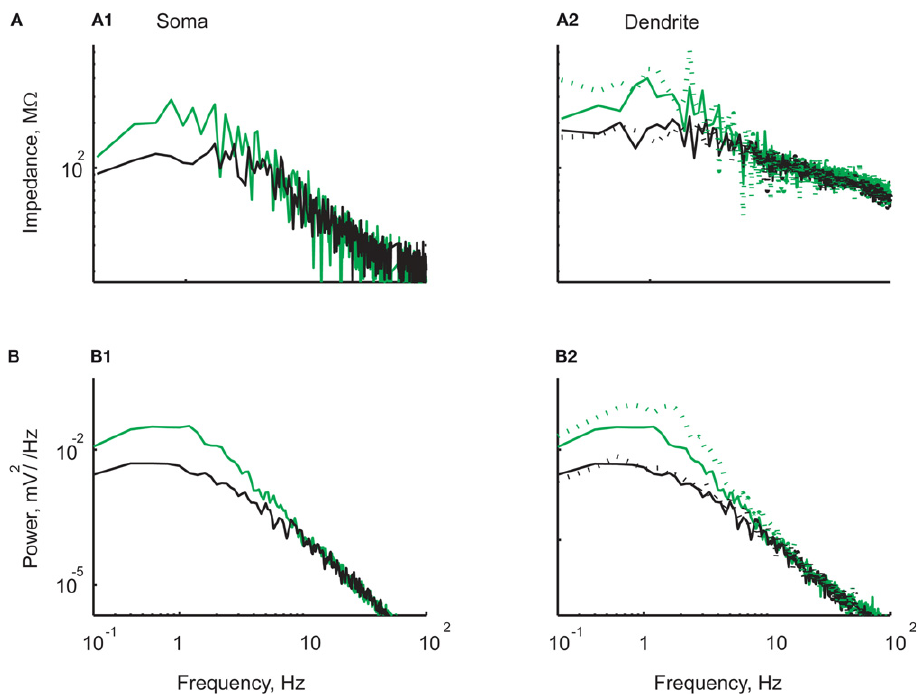
Figure 5 | TTX decreased noise and impedance in both soma and dendrite. The impedance (A) and noise spectra (B) at the soma (left panels) and the dendrite (right panels). In all panels the results obtained are shown before (green) and following (black) addition of TTX to the bath solution. (A1) impedance at the soma at resting potential. (A2) Impedance at the dendrite at resting potential (solid lines) and at a depolarization of 9 mV (dashed lines). (B1) Noise power spectrum at the soma at resting potential. (B2) Noise power spectrum at the dendrite at resting potential (solid lines) and at a depolarization of 9 mV (dashed lines). Note the decrease in noise level and impedance at low frequencies following TTX. Also note that the voltage dependence of both impedance and noise in the dendrite is abolished by addition of TTX.